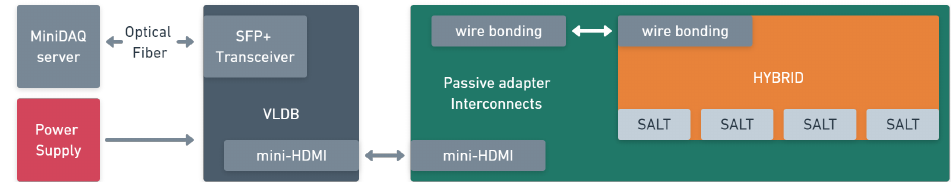
Figure 10. Block diagram of the DAQ used for SALT